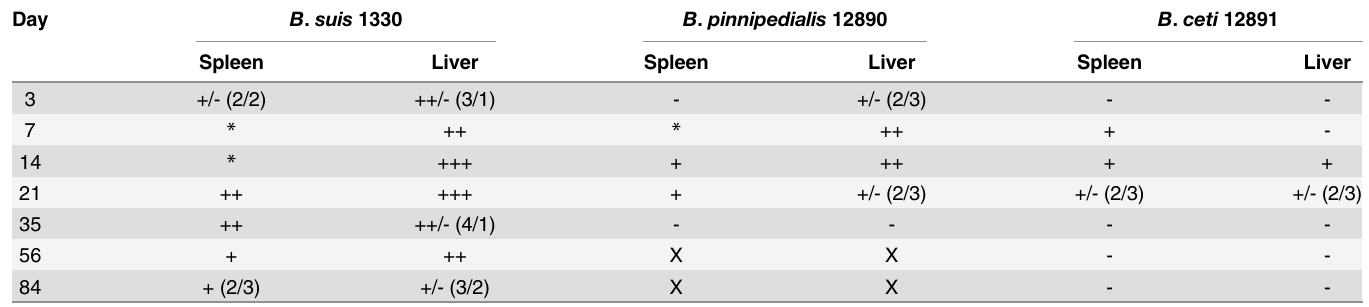
spleen and liver histopathology at day 14 are presented in S3 Fig. Except for the enlargement of spleen and liver, no gross pathology was observed. Table 2. Histopathological findings in spleen and liver.